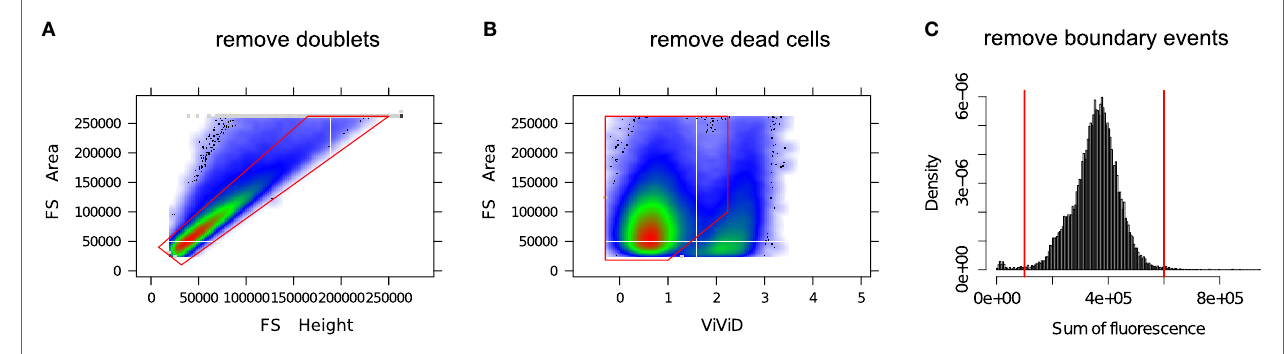
FigUre 2 | removing unintended events from an Fc sample . (a) Single intact cells (inside the red polygon gate) are separated from the doublets (outside of the red polygon gate). (B) A viability marker (ViViD) is used to remove dead cells (outside of the red polygon gate). (c) Cells emitting very low or very high fluorescence signals (outside of the red vertical lines) are removed as potential outlying